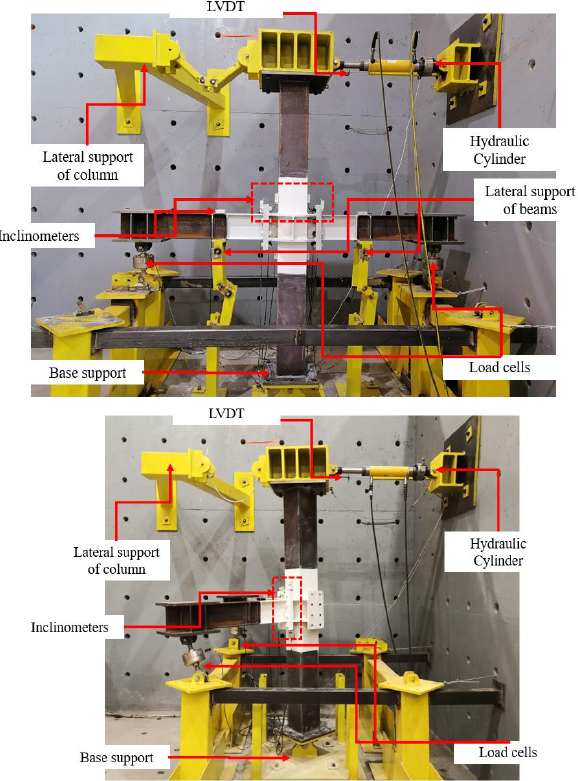
Figure 3. Experimental setup.